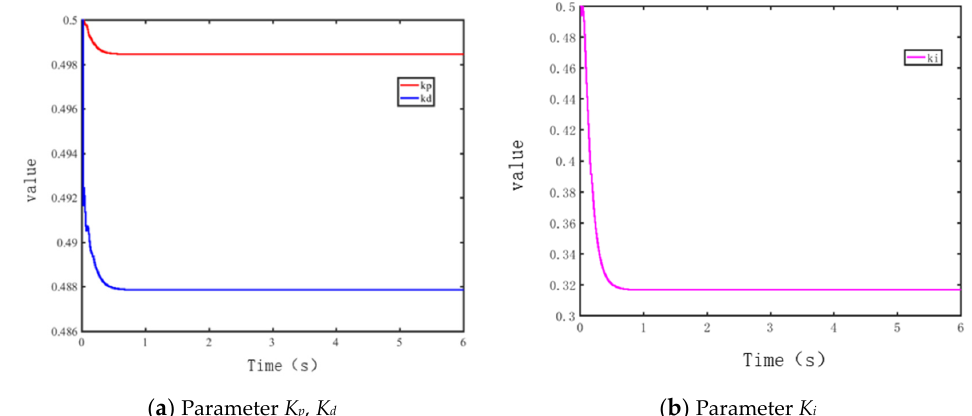
Figure 15. BP_ Controller parameter variation curve.